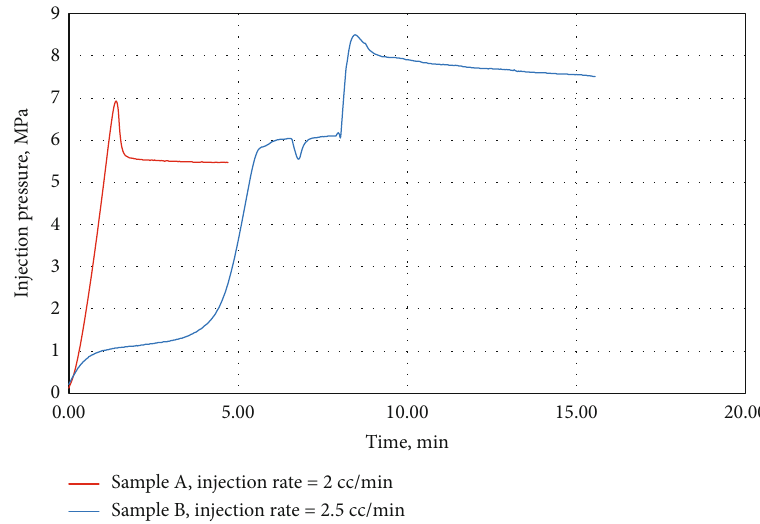
Figure 9: Injection pressure response for samples A and B shown in Figure 8.